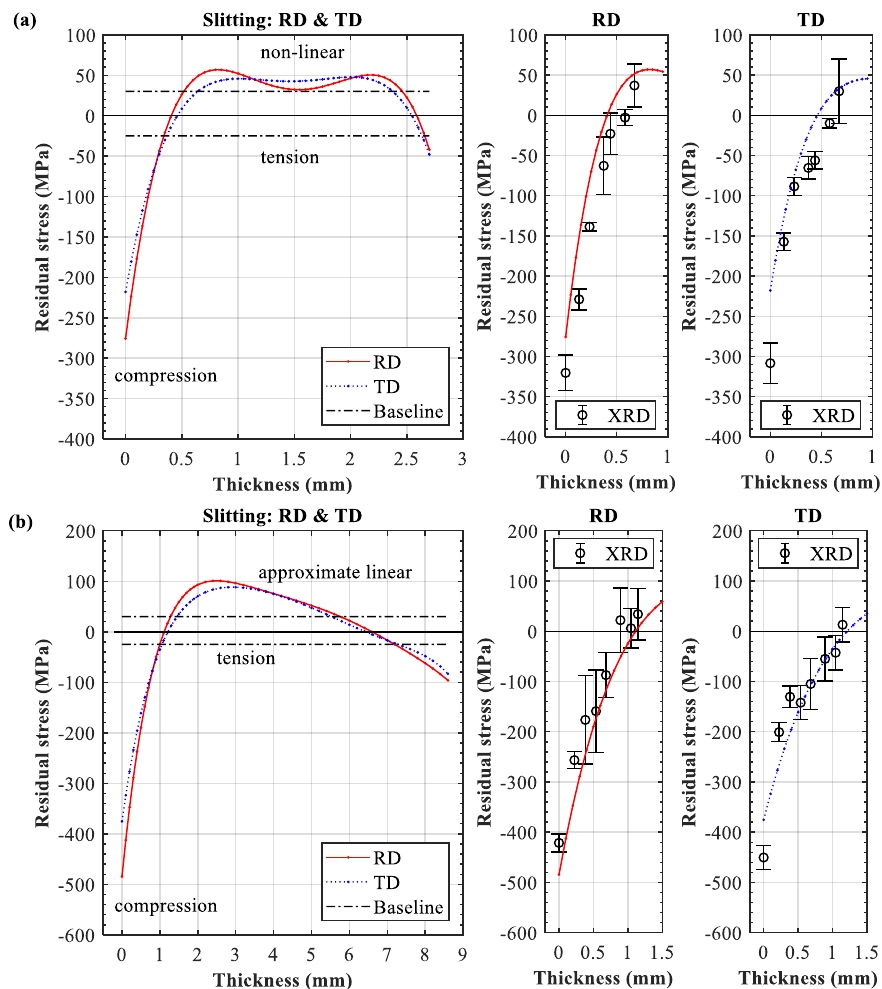
Figure 2. Spatial distributions of residual stress in the sheets formed by laser peen forming (LPF): ( a ) 3-mm sheet and ( b ) 9-mm sheet.